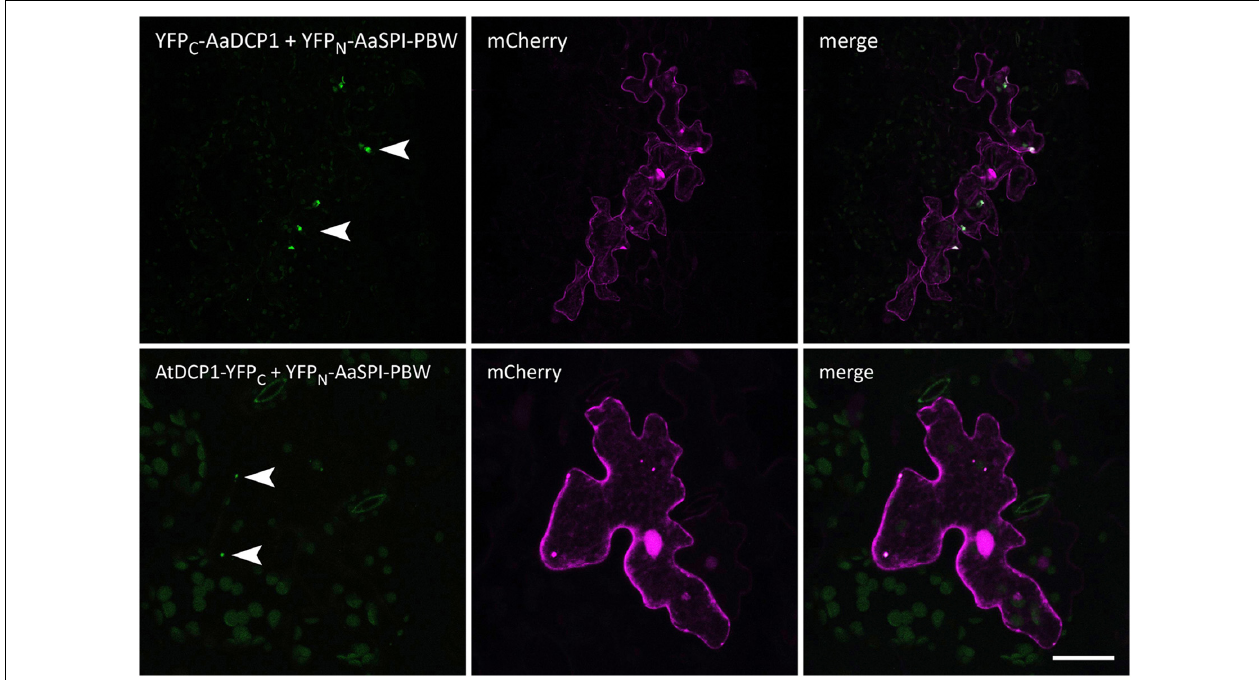
FIGURE 7 | BiFC interactions of AaSPI-PBW with the P-body component DCP1 from A. thaliana and A. alpina . Left—BiFC, middle—transformation control, right—overlay of BiFC and transformation control. Arrow heads indicate sites of interaction. Scale bars: 25 µ m.